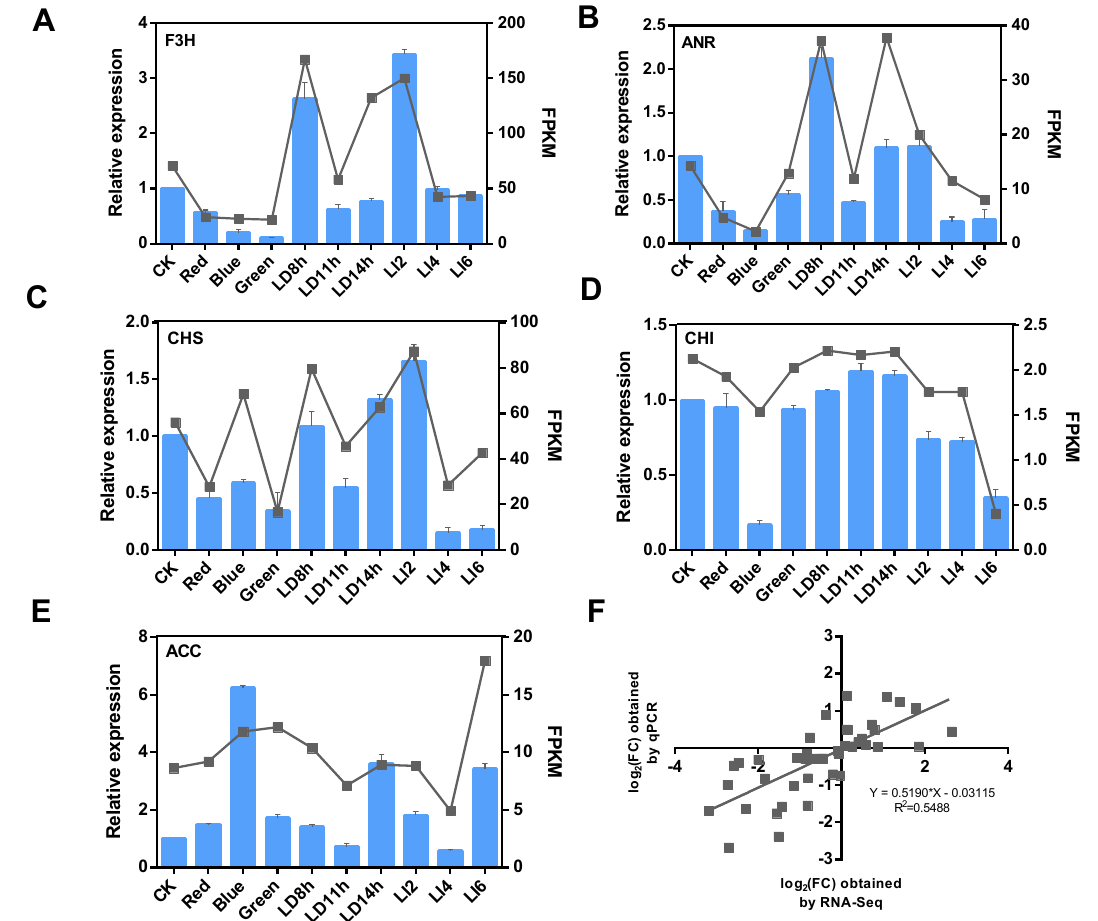
Figure 8. Light-induced L. polystachyus gene expression determined by qRT-PCR. ( a – e ) Expression levels of selected genes. The y-axis on the left indicates the relative expression levels determined by qRT-PCR (blue histogram), whereas the y-axis on the right indicates the expression levels based on the RNA-seq data (gray line chart). The x-axis indicates the light treatments. ( f ) Comparison between the log2 fold-changes calculated based on the RNA-seq and qRT-PCR